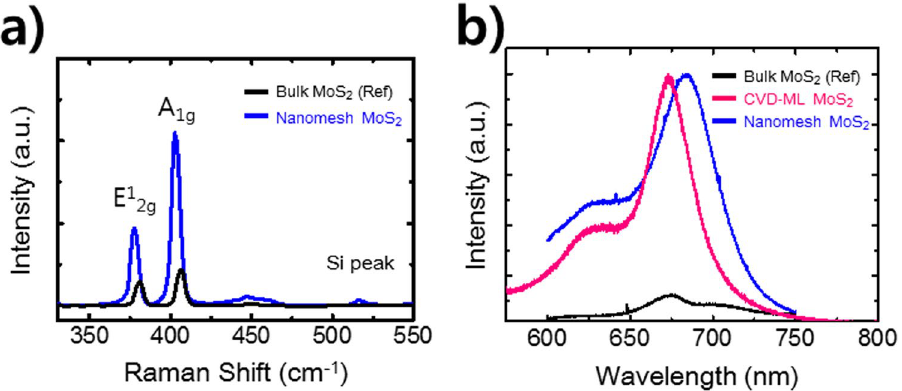
Figure 4. ( a ) Scanning Raman spectrum and ( b ) scanning PL spectrum of bulk MoS 2 , CVD-grown monolayer MoS 2 , and nanomesh MoS 2